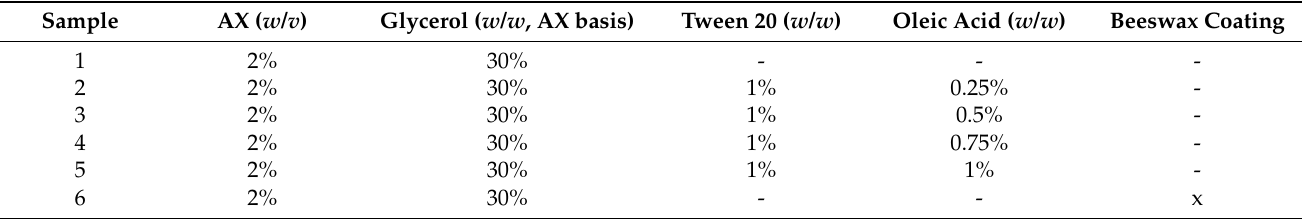
Table 1. Composition of each sample for the film